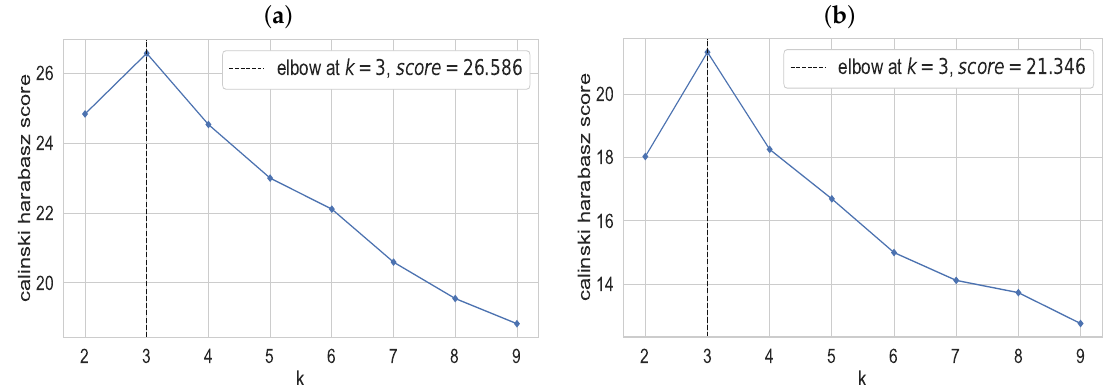
Figure 3. The curves of the CH-index according to the number of clusters for ( a ) global representation and ( b ) local